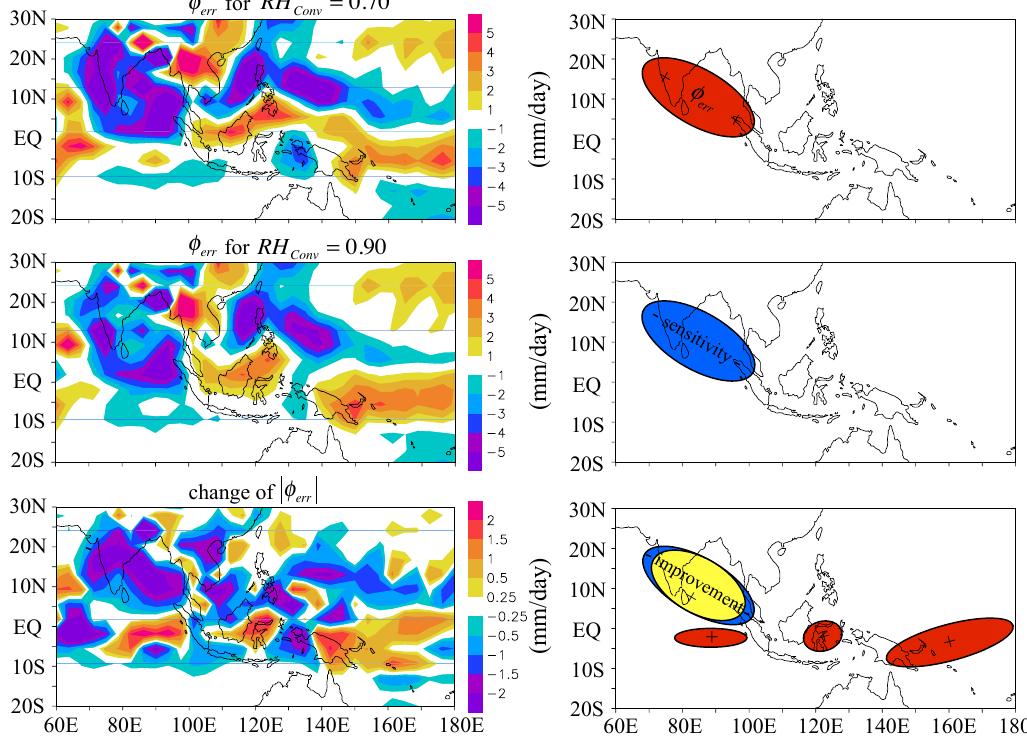
Fig. 7. On left, top: error of the AGCM precipitation climatology with all µ i at standard value, middle: as above but with RH Conv at its optimum (RH Conv = 0 . 90), bottom: absolute value of the model error difference between top and middle panels. On right: schematic showing the region where error is largest (top), where sensitivity to RH Conv is greatest (middle), and where parameter optimization improves (in yellow) or downgrades (in red) model performance (bottom). All plots focus on the Indian Ocean and western Pacific